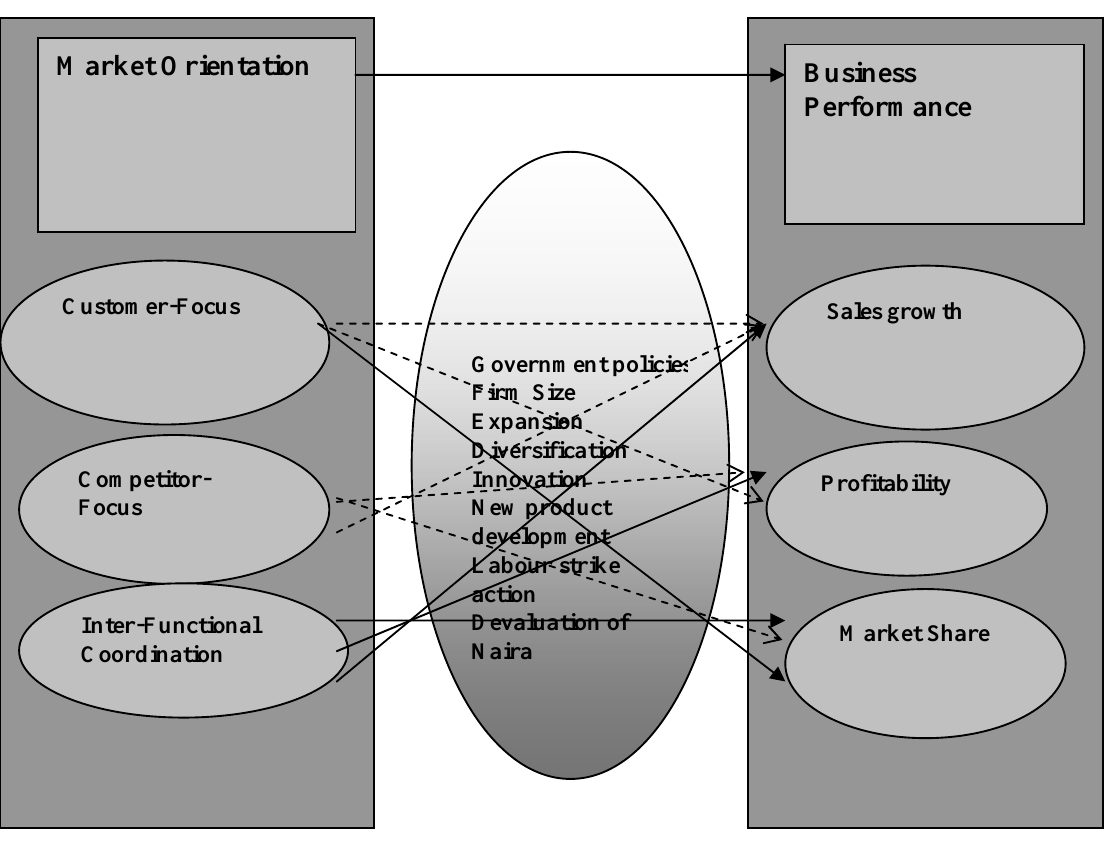
Figure 2: Market Orientation – Business Performance